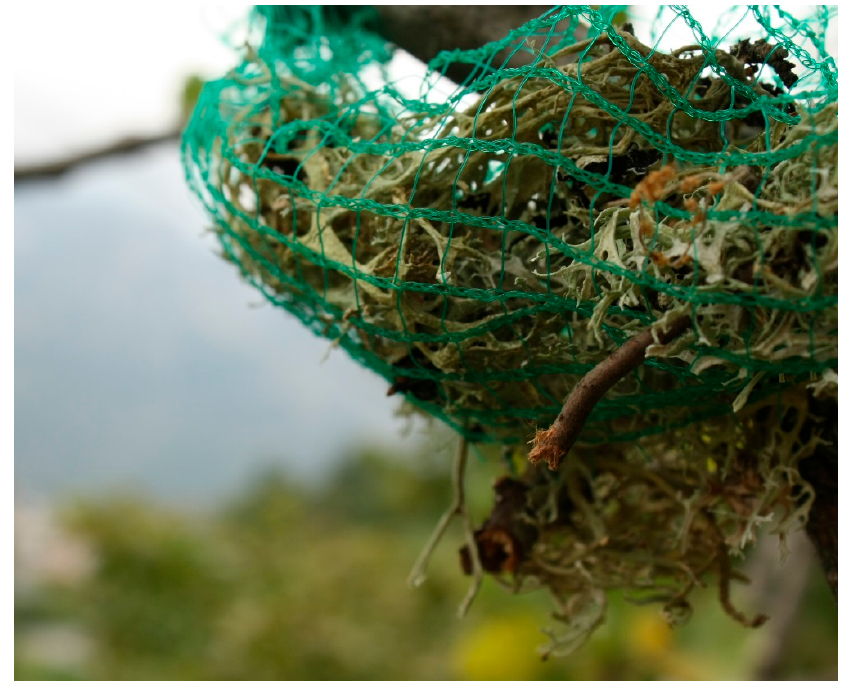
Figure 1. A lichen bag exposed in the study area.